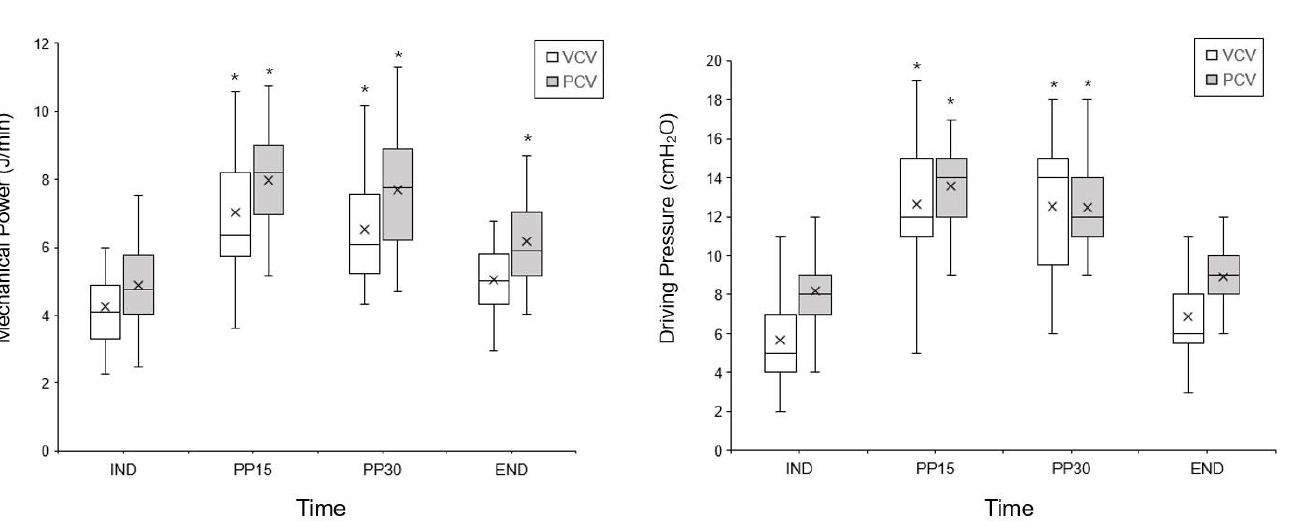
Table 2. The change in dynamic mechanical power and dynamic driving pressure during the sur- gery.